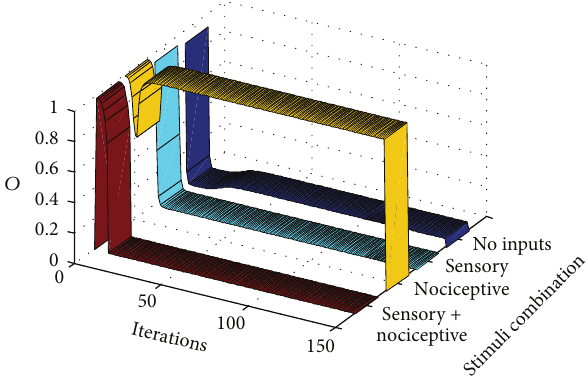
Figure 4: This graph shows the output, 𝑂 , of the CT neuron in the gate circuit along computer iterations. It shows that the circuit quickly adapts, for eliciting standard gate outputs when standard pain and sensory signal are input to the circuit (a standard training epoch is given to the circuit in each iteration). Each ribbon represents the output of the circuit when a certain combination of inputs is introduced as input to the circuit. The dark blue ribbon yields the output (the CT neuron action potential probability) when no inputs are introduced. Cyan, yellow, and red ribbons yield the CT neuron output under conditions in which only sensory, nociceptive, or both inputs are, respectively, input to the gate